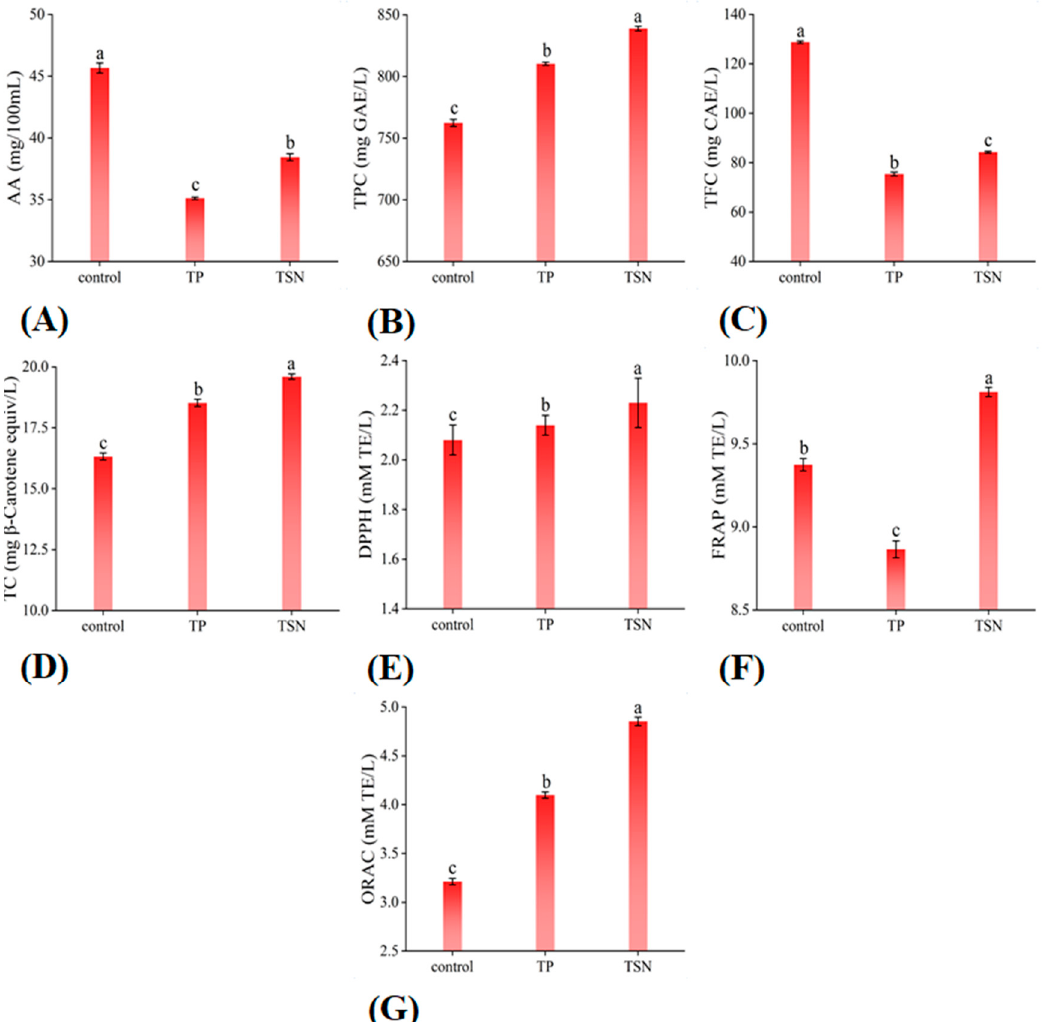
Figure 4. Effects of different sterilization treatments on the functional indicators of orange juice. ( A ) AA; ( B ) TPC; ( C ) TFC; ( D ) TC; ( E ) FRAP assays; ( F ) DPPH scavenging activity; ( G ) ORAC assays.